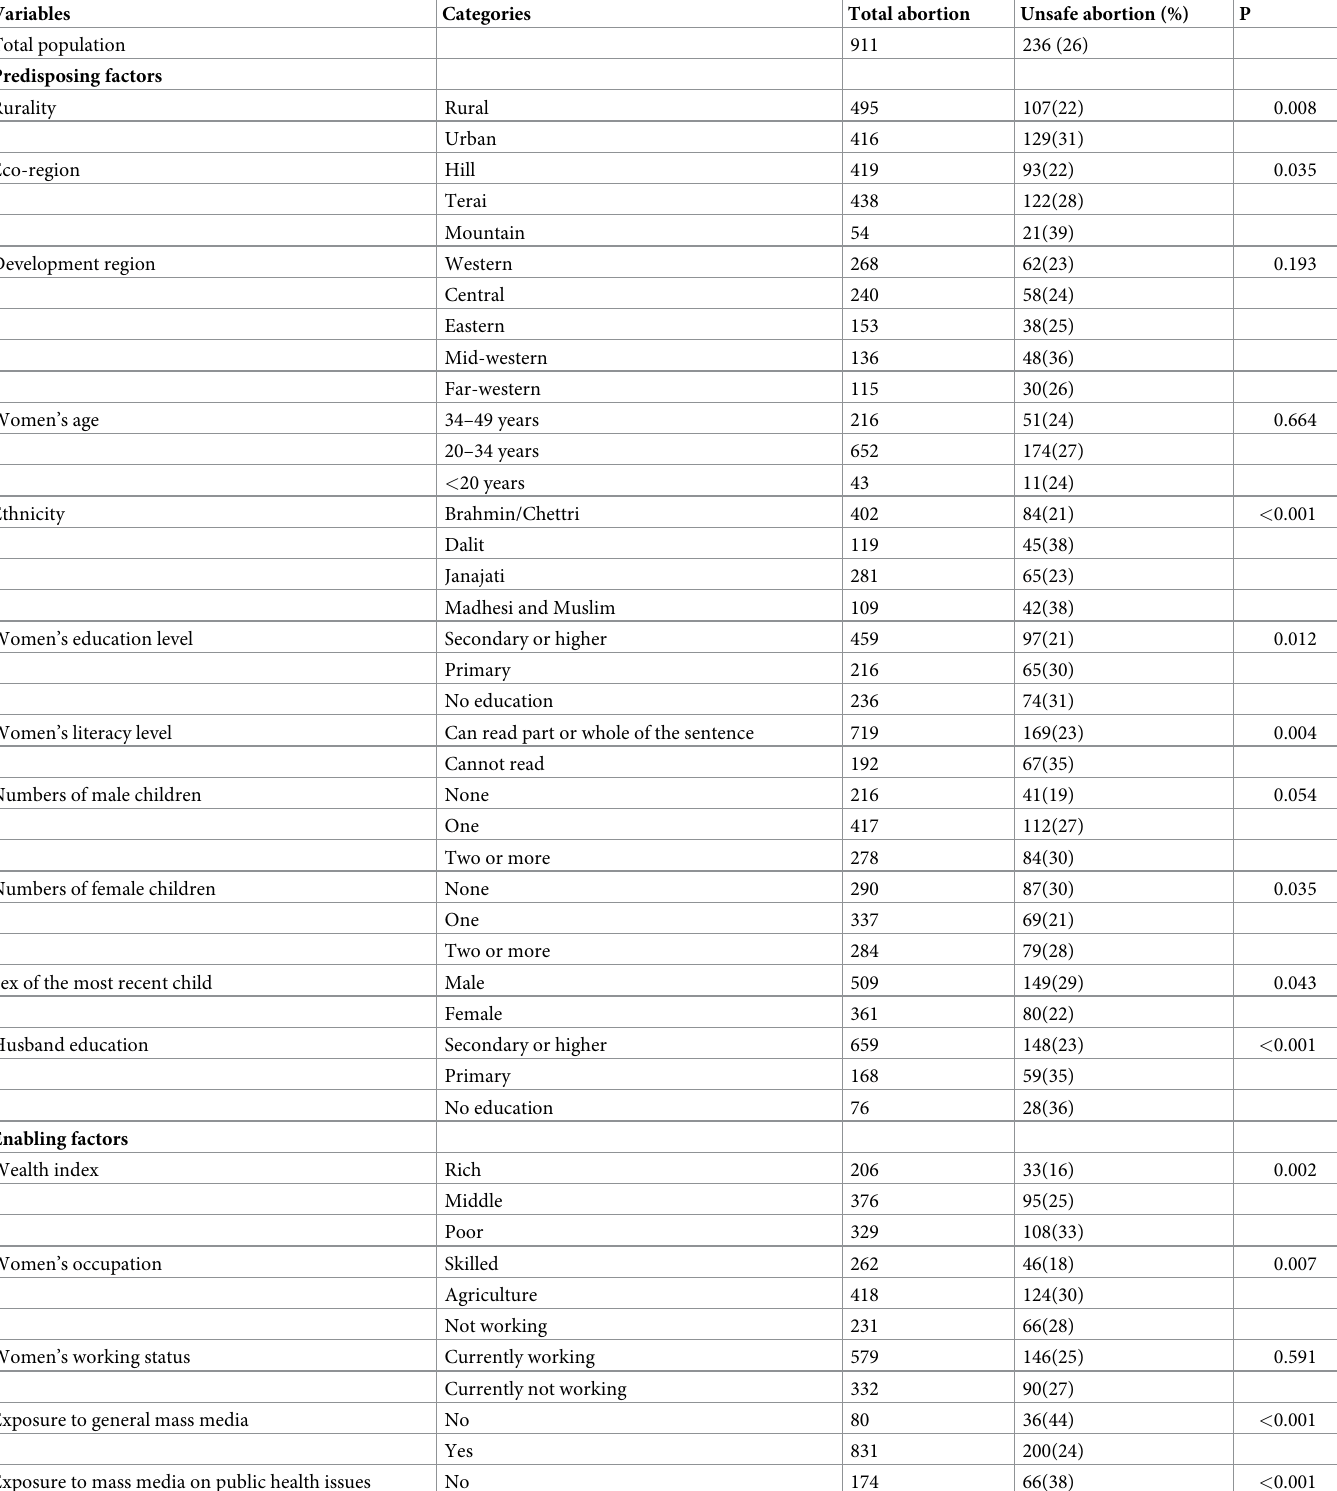
Table 1. Descriptive characteristics of the study population and the proportion of unsafe abortion in Nepal, 2011–2016 (N =